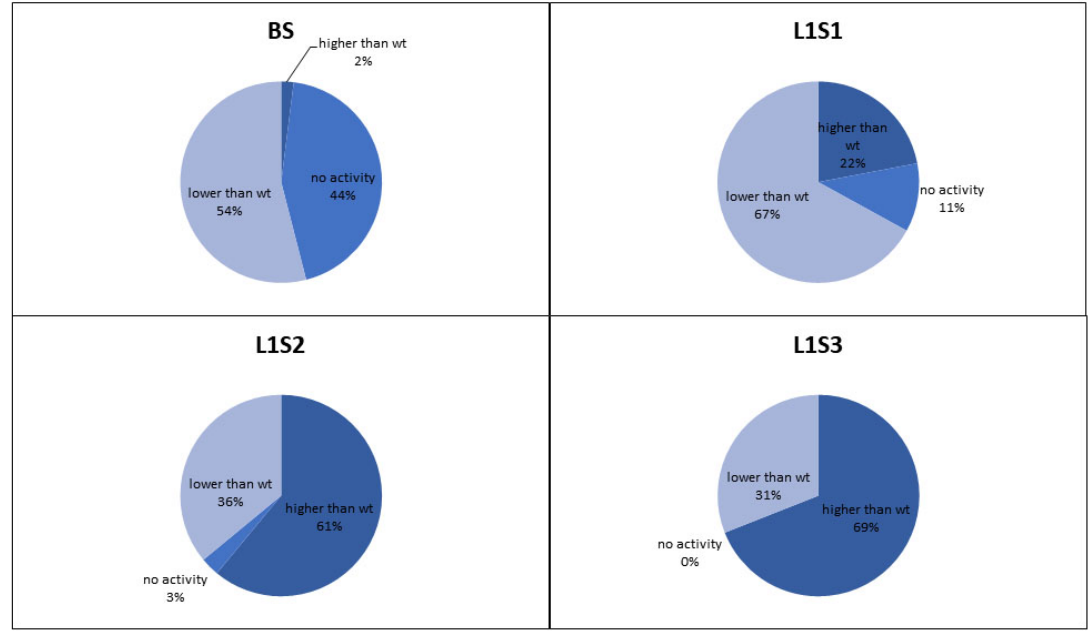
Figure 4. Proportion of glucose oxidase variants in the L1 library based on activity compared to the wild-type enzyme. The charts show the proportion of variants with no activity, less than wild-type activity, and more than wild-type activity before sorting ( BS ), and after the first ( S1 ), second ( S2 ) and third ( S3 ) rounds of sorting.